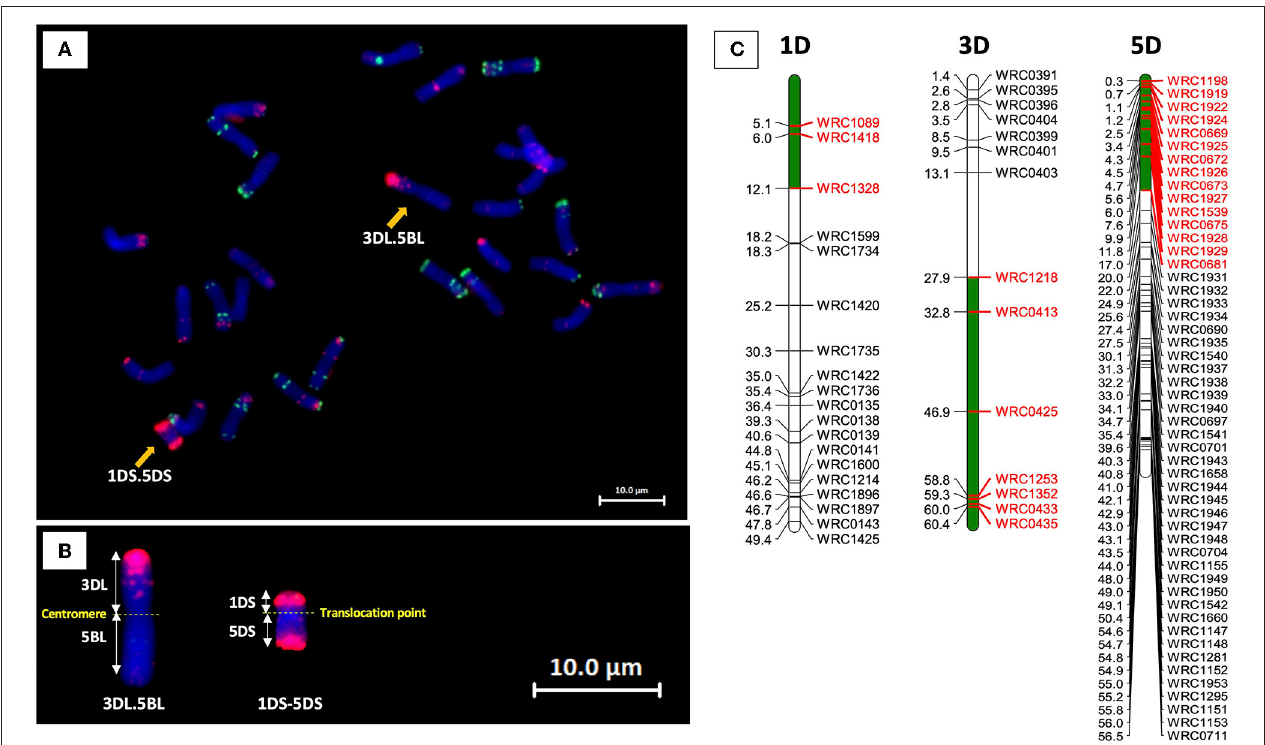
FIGURE 5 | (A) Mc-FISH of a metaphase spread of BC 1 F 2 -250-3 showing the presence of a centromeric 3DL.5BL translocation and 1DS − 5DS chromosome rearrangement (yellow arrows). (B) Enlarged images of the 3DL.5BL and 1DS.5DS translocated chromosomes. (C) KASP genotyping showing the D-genome segments in green with associated KASP markers shown in